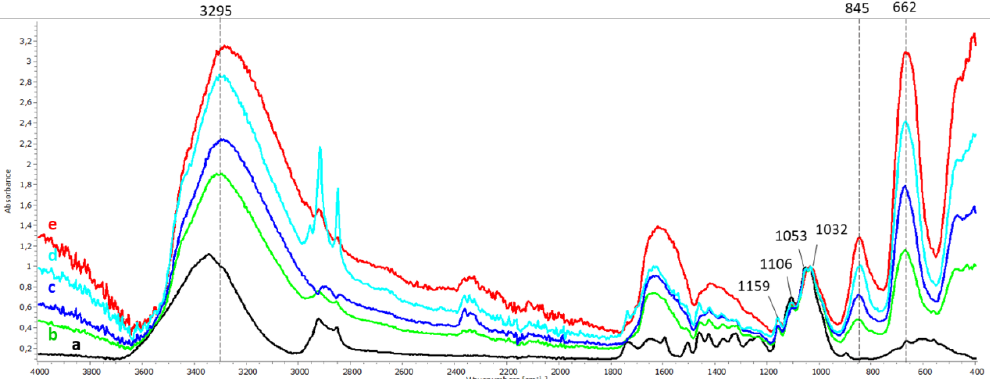
Figure 7. ATR-FTIR spectra of mock-ups after 8 applications of DFO-B at pH 8.6 ( b ), at pH 6.5 ( c ) and dissolved in ethanol ( d ) in comparison to the maple reference spectrum ( a ) and a stained mock-up before the cleaning treatment ( e ). Spectra were normalized with respect to the holocellulose peak at 1032 cm − 1 .